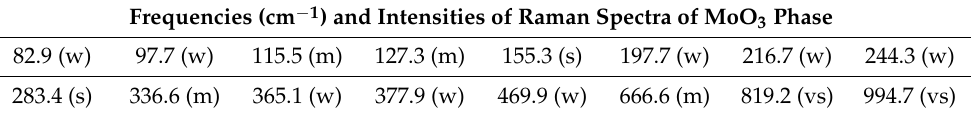
Table 4. Measured peaks of MoO 3 phase in the Raman spectra of Figures 17 and 18. The intensities are given in brackets as w = weak, m = medium, s = strong and vs = very